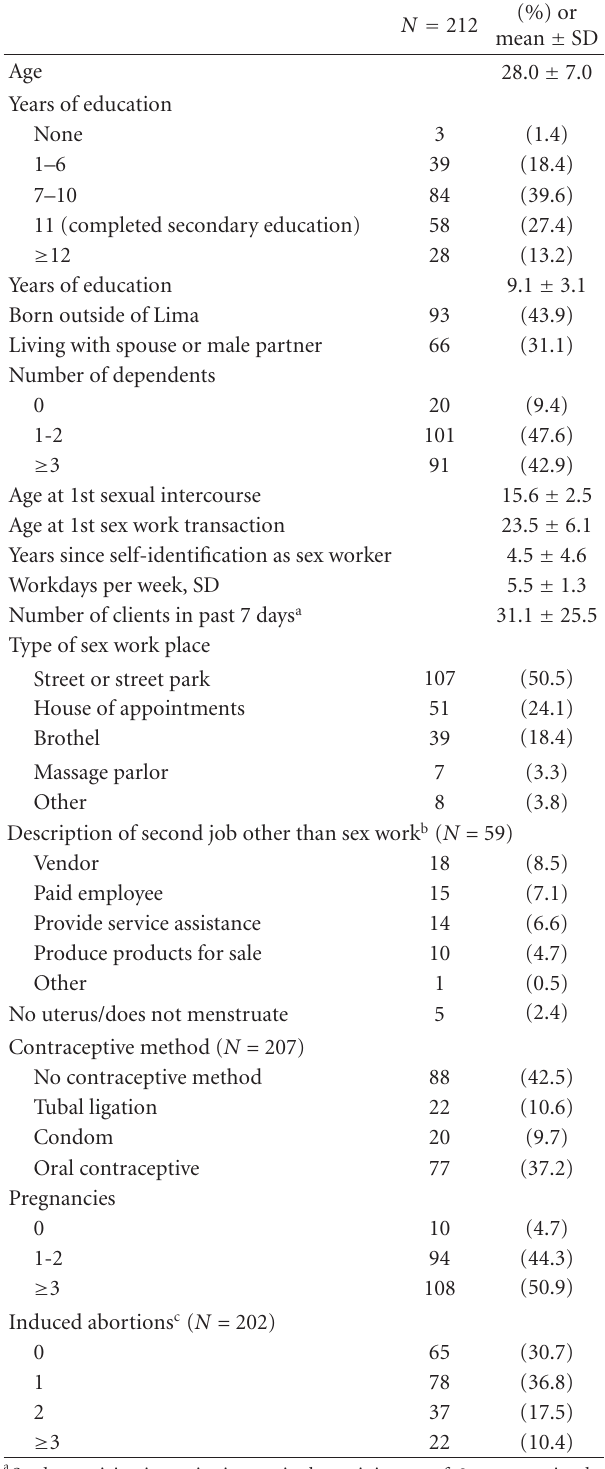
Table 1: Demographic, sex behavior, and reproductive health char- acteristics of 212 clandestine female sex workers: Lima, Peru,